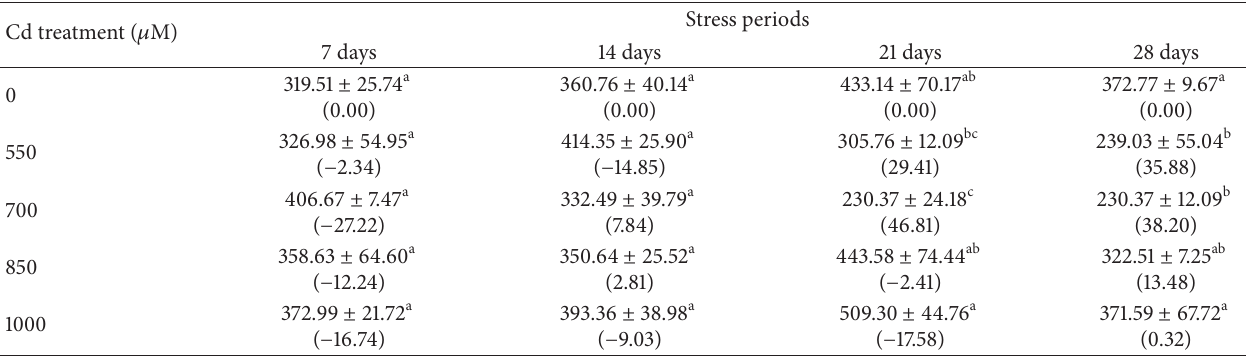
Table 5: SOD activity (Ug − 1 FW) of cotton callus culture (cv. YZ1) grown under various levels of cadmium. Cd treatment ( 𝜇